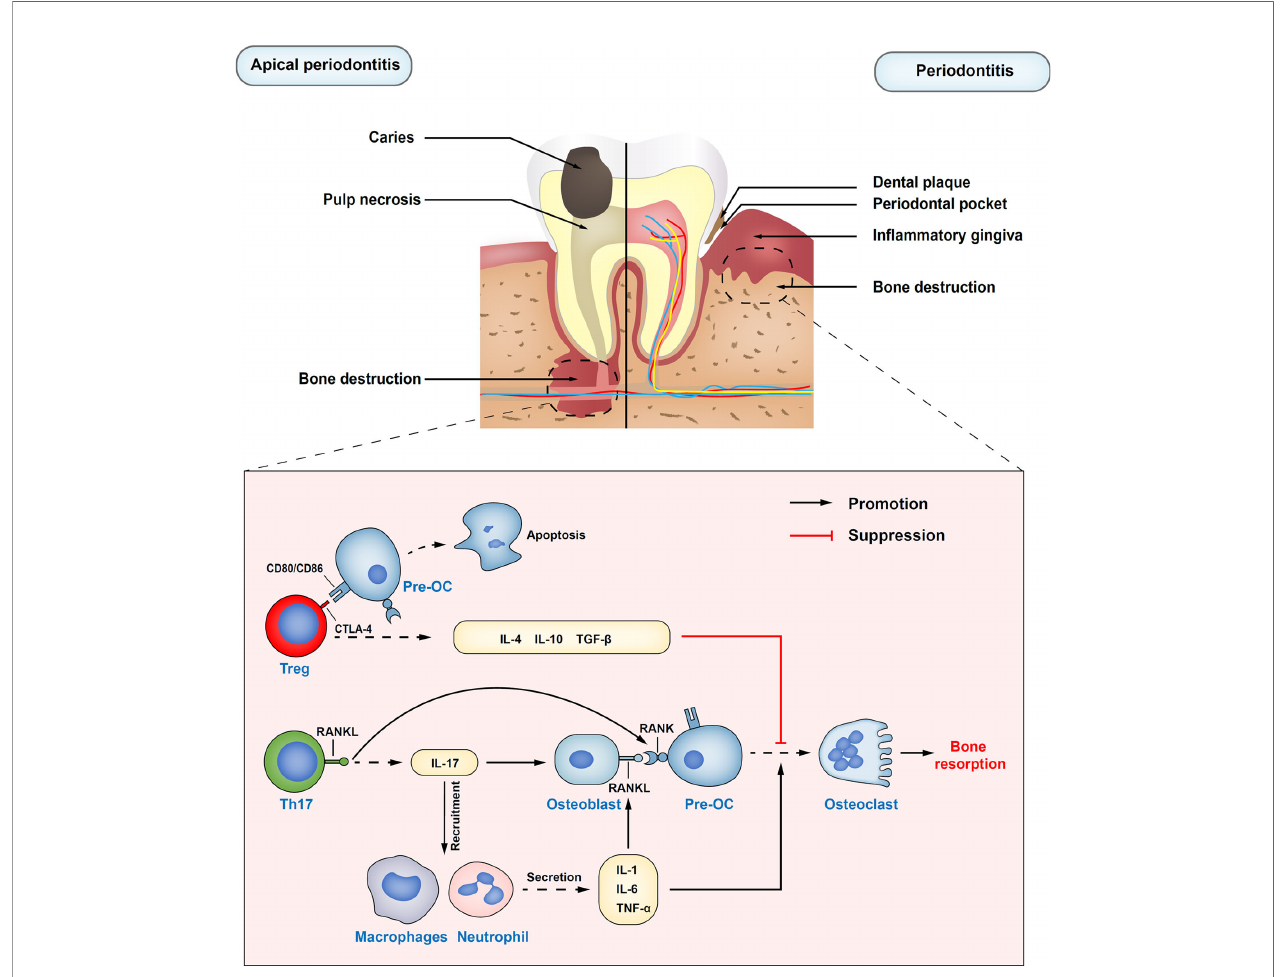
FIGURE 1 | Immune regulatory functions of Treg cells in apical periodontitis and periodontitis. Treg cells inhibit the differentiation of osteoclast precursors into osteoclasts by secreting inhibitory cytokines, such as IL-10, IL-4, and TNF- b . Also, inhibiting receptor cytotoxic T-lymphocyte – associated antigen 4 (CTLA-4) on Treg cells directly in contact with osteoclast precursors costimulatory molecules CD80 and CD86, which can induce the production of indoleamine 2,3-dioxygenase (IDO) and induce the apoptosis of osteoclast precursors. Th17 cells upregulate osteoblasts and self-expressed receptor activator of nuclear factor kappa B ligand (RANKL) through the release of in fl ammatory cytokine IL-17. At the same time, IL-17 plays an important role in the mobilization and recruitment of immune cells, stimulating the release of local in fl ammatory factors, resulting in the expansion of osteoclasts, and the aggravation of in fl ammatory response. Pre-OC, osteoclast precursors; RANK, the receptor activator of nuclear factor kappa